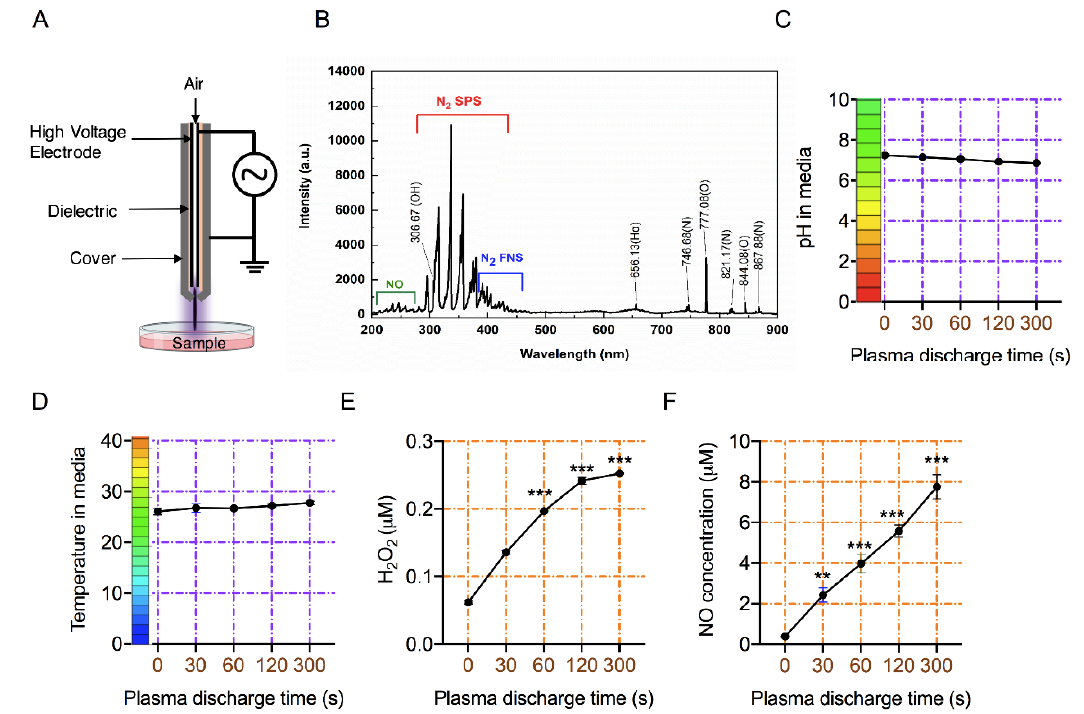
Figure 1. Characterization and standardization of plasma device. ( A ) Schematic of air gas jet plasma device; ( B ) Optical emission spectrum of plasma-generated species in ambient air; ( C , D ) pH and temperature of media after exposure to plasma for various periods, respectively; ( E , F ) Determination of H 2 O 2 and NO x concentrations in medium after plasma exposure for indicated periods. ** p < 0.01 and *** p < 0.001.